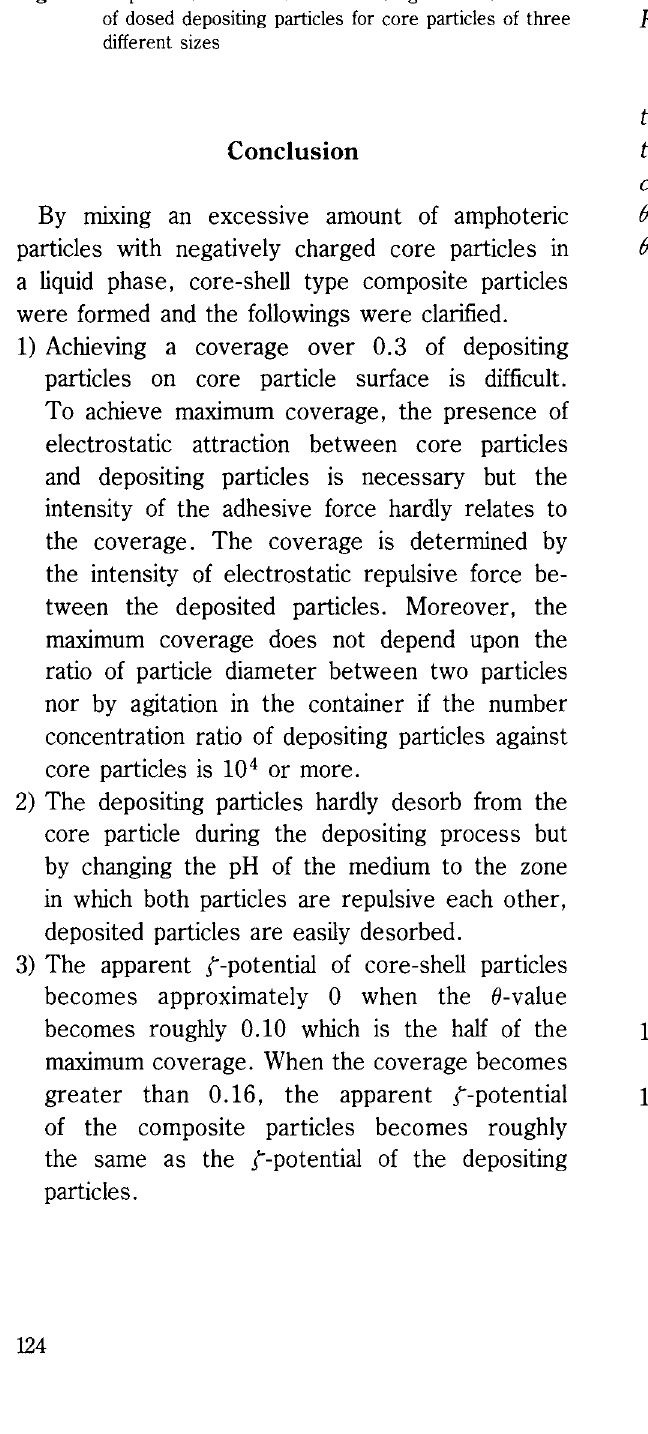
Fig. 12 Dependence of the maximum coverage on concentration of dosed depositing particles for core particles of three different sizes